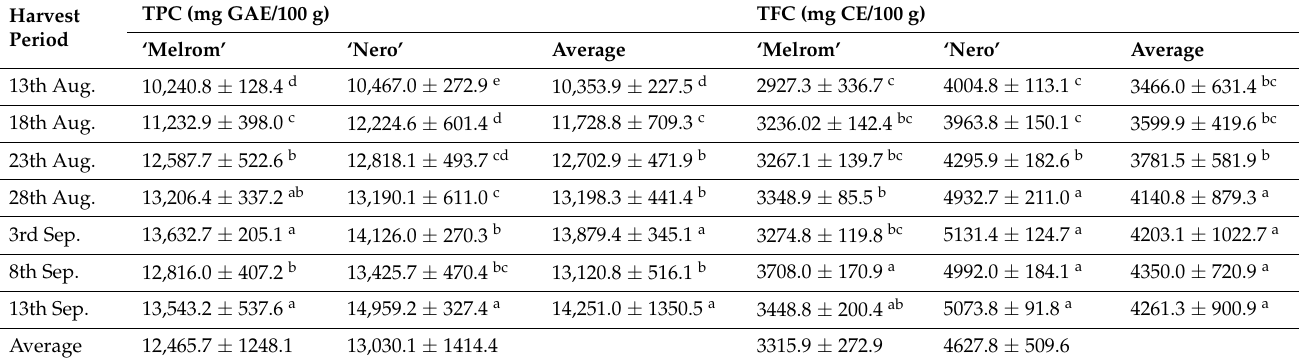
Table 2. Variations in total phenolic content (TPC) and total flavonoid content (TFC) in dehydrated chokeberry pomace during the harvest season *.